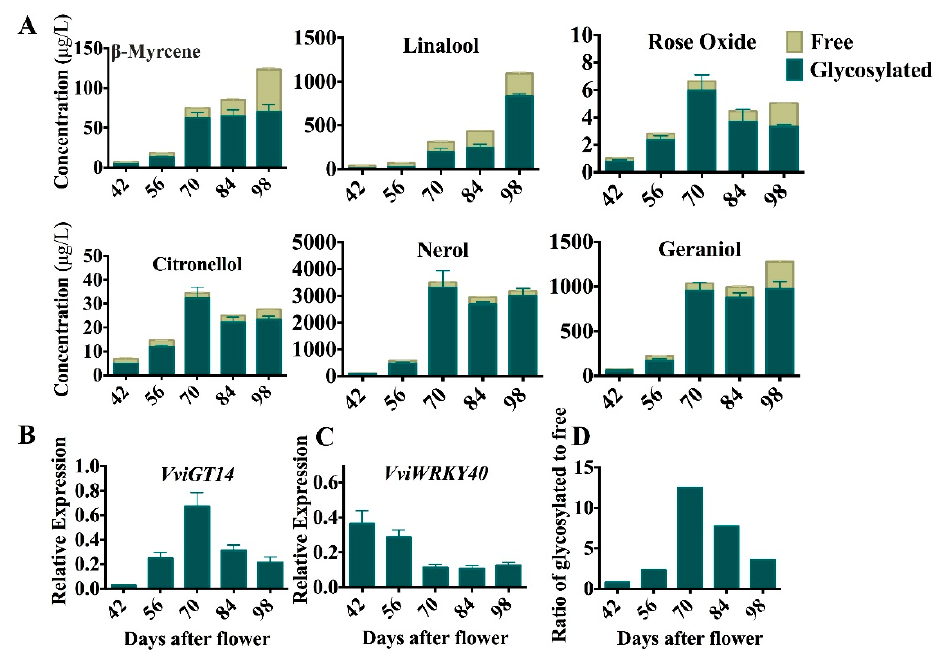
Figure 8. Accumulation of main monoterpenes and the expression of VviWRKY40 and VviGT14 during Vitis vinifera L. “Muscat blanc à Petit grain” grape berry ripening, mean values and SE were calculated from three independent experiments. The data are expressed as mean ± SD of three replications in A , B and C , A. Change in the concentration of main monoterpenes during berry ripening. B. Relative expression of VviWRKY40 during berry ripening. C. Relative expression of VviGT14 during berry ripening. D. Ratio of glycosylated monoterpenes to free.